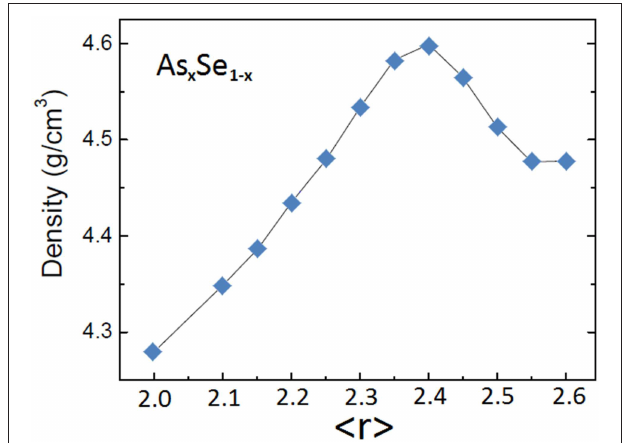
FIGURE 8 | Density of Ge-Se glasses as a function of average coordination < r > . Data from Yang et al. (2013).